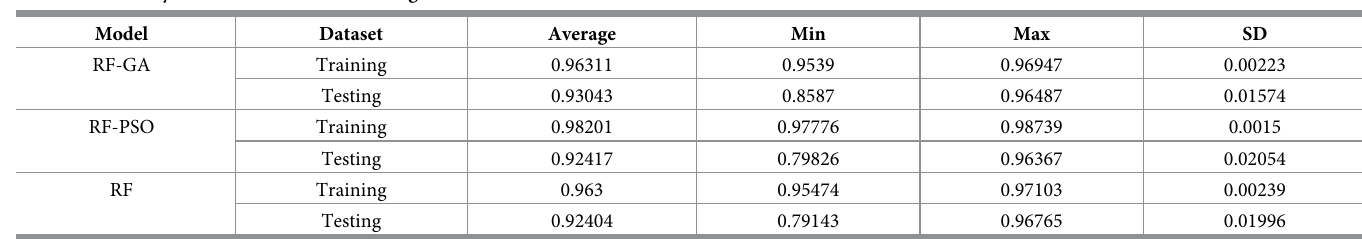
Table 5. Summary of the 1000 simulations using R2 criteria.